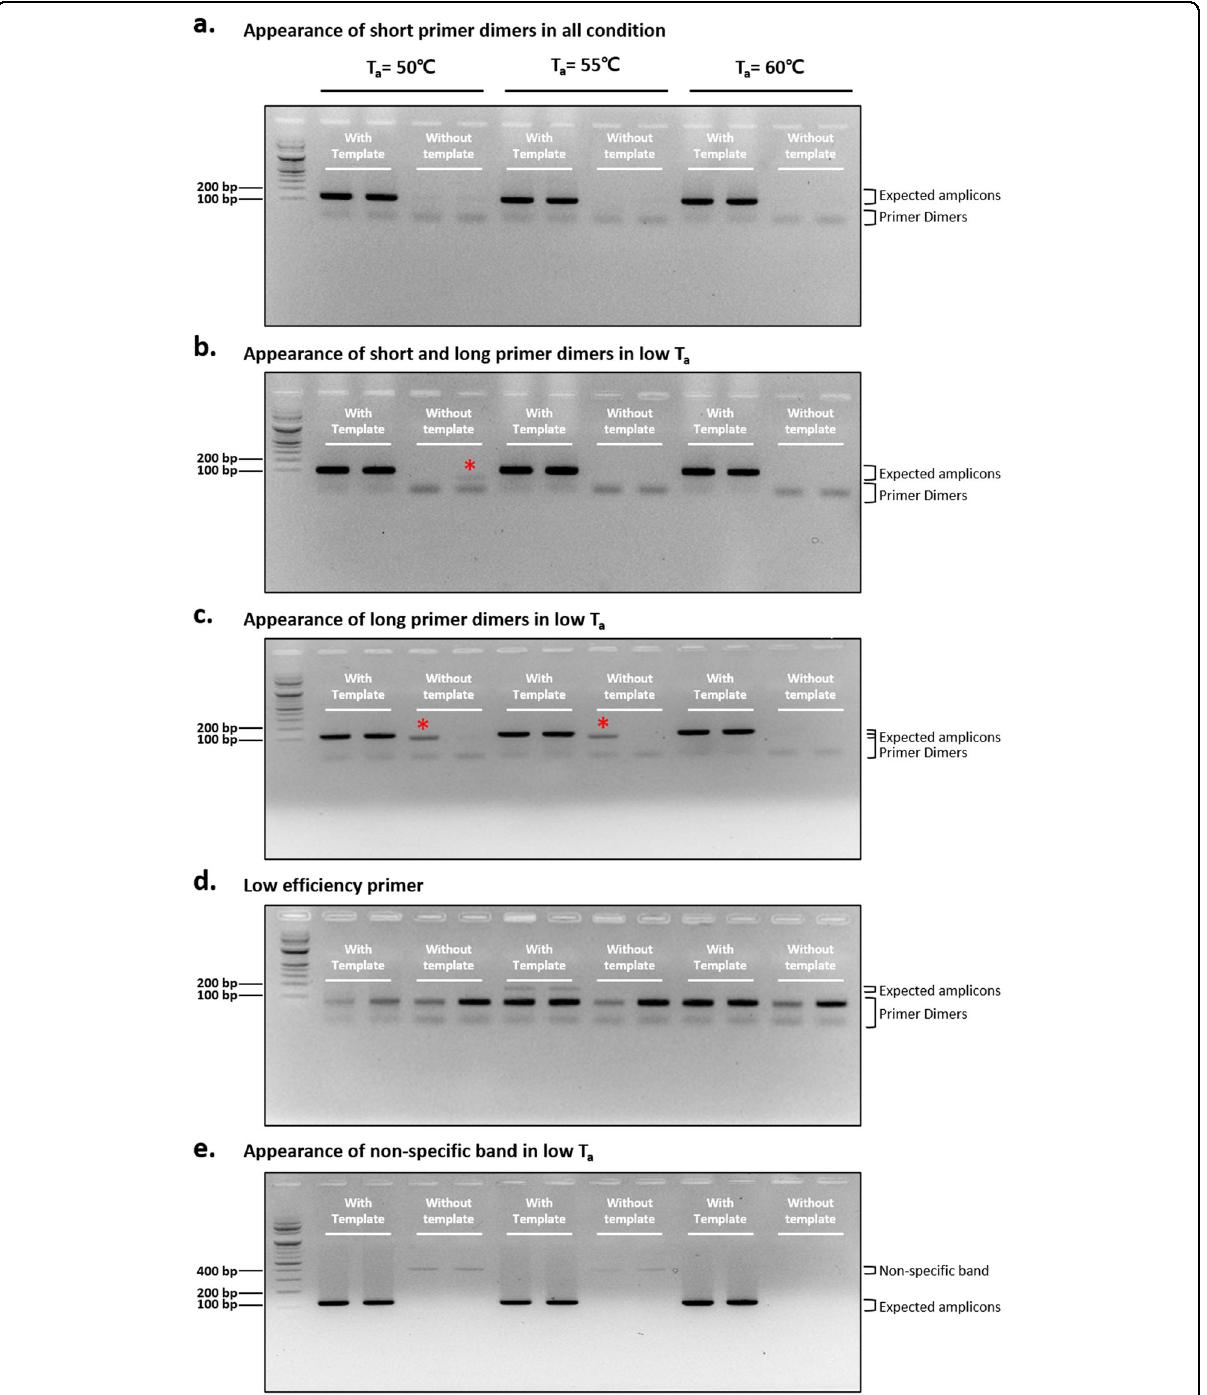
Fig. 2 Examples of nonoptimal primer set test results using PCR. Electrophoresis results after PCR (35 cycles) with various nonoptimal primer sets with or without template DNA (SARS-CoV-2 cDNA) and under different T a conditions. a An example of the appearance of short primer dimers in all conditions, performed with the SARS-CoV-2_IBS_RdRP1 primer set. b An example of the appearance of short and long primer dimers under a low T a , with the SARS-CoV-2_IBS_S1 primer set. c An example of the appearance of long primer dimers under a low T a , with the SARS-CoV-2_IBS_E1 primer set. d An example of low-ef fi ciency primers in PCR performed with the CDC_RNAse P primer set. e An example of the appearance of a nonspeci fi c band at a low T a , in PCR performed with the SARS-CoV-2_IBS_N1 primer set. Red asterisks indicate long primer